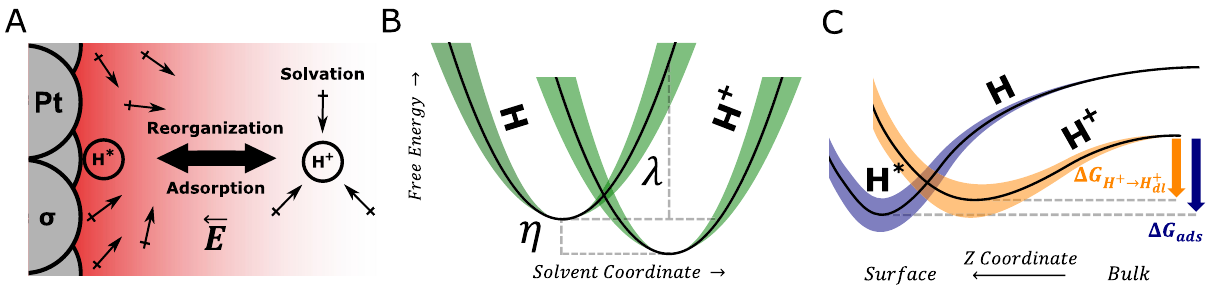
Fig. 1 | Schematics of Volmer reaction along the collective solvent coordinate and proton-surface distance, z. A Illustration of chemisorption and solvent reorganization around H + in the Volmer step at charged Pt (111). Approaching the electrode, H + moves through the interfacial fi eld and loses signi fi cant solvation energy before reaching the charge transfer transition state. B Diabatic free energy curves of the H + = H pair at fi xed z; solvent reorganization energy, λ , and over- potential, η ,areshown.ChangesintheEDL fi eld strengthcanpotentiallymodulate solvent polarization fl uctuations, which in turn determines the free energy